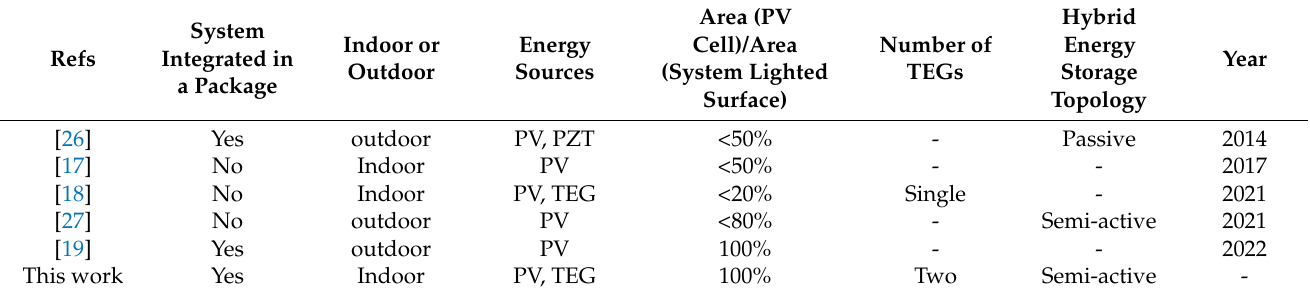
Table 1. Related work in recent